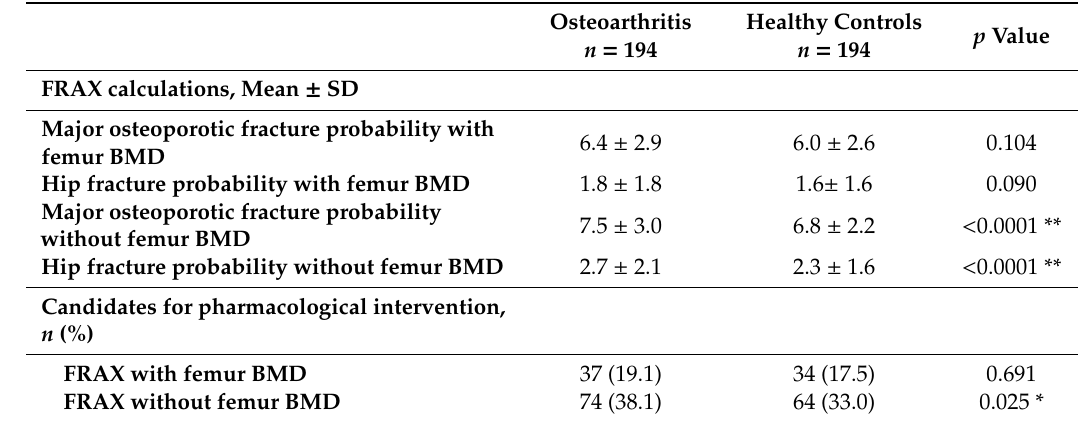
Table 6. Comparison of 10-year fracture probabilities calculated using the FRAX, and candidates for pharmacological intervention by the FRAX criteria in patients with knee osteoarthritis and healthy controls, except those with previous fractures and male patients.